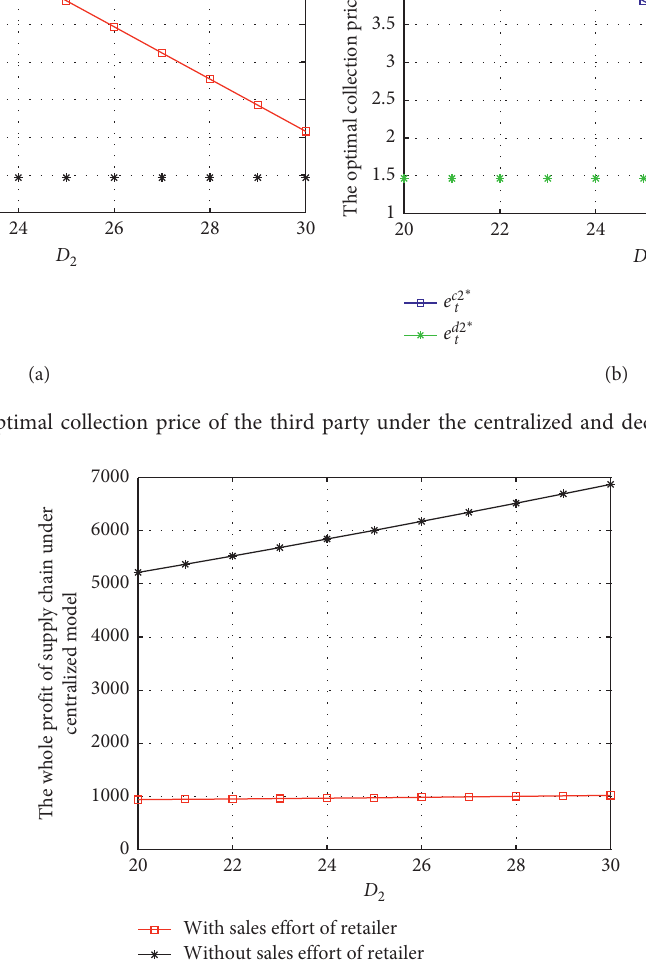
Figure 7: The optimal profit of whole supply chain with sales effort under the centralized model.